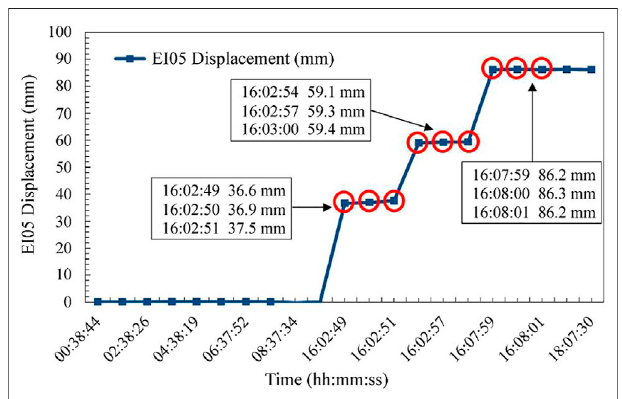
FIGURE 14 | Displacement curve of monitoring point,